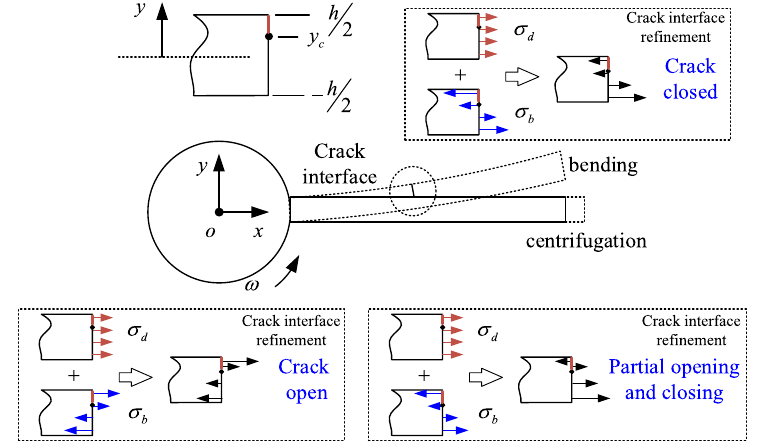
Figure 5. Schematic diagram of crack breathing in a rotating